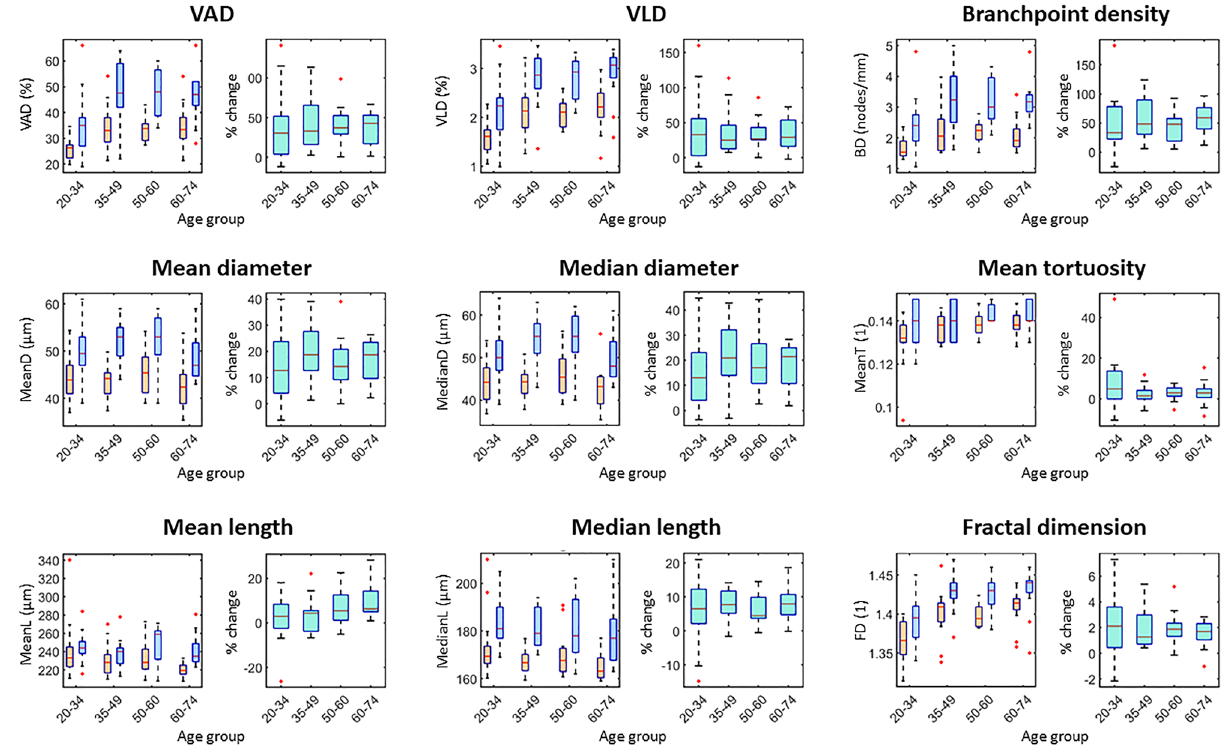
Figure 3. Box plots of age-dependent healthy reference values for selected metrics in the foot. For each metric, the left plot shows the values at baseline (orange) and PORH (blue) and the right plot shows the % change (turquoise). Red lines indicate the median value, boxes indicate the 25th and 75th percentiles, and the black dotted lines indicate the range. Outliers are indicated by red crosses. A unit of 1 indicates a dimensionless metric. VAD vessel area density, VLD vessel length